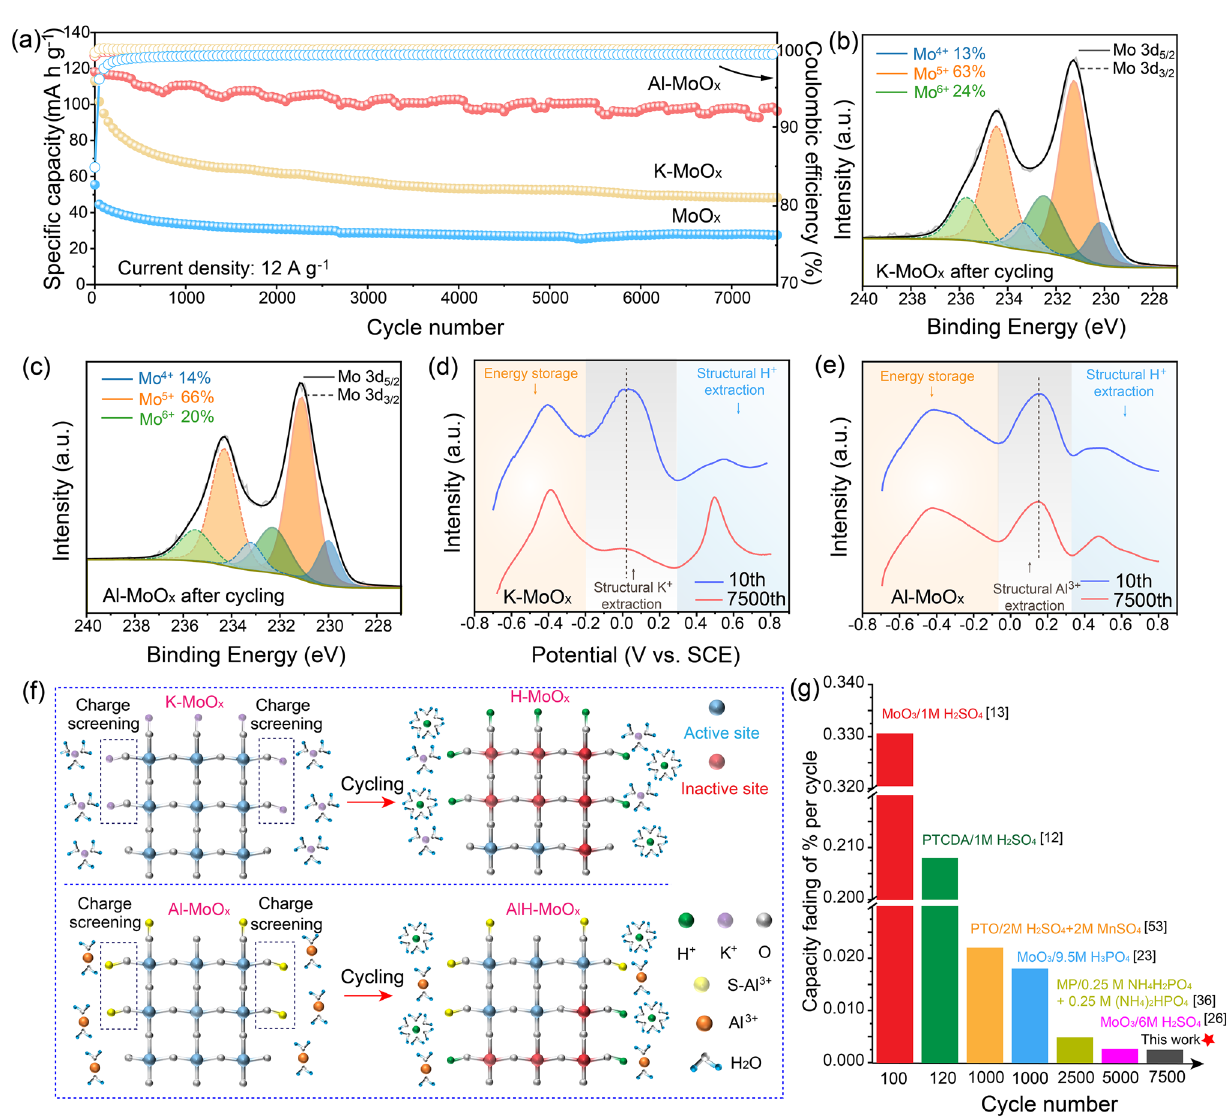
Fig. 4 Analysis of high cyclic stability. a Cycling stability of MoO x , K-MoO x and Al-MoO x . Mo 3d XPS spectra of b K-MoO x and c Al-MoO x after 7,500 cycles. LSV curves of structural cation extraction for d K-MoO x and e Al-MoO x before and after cycling. f Schematic illustration of energy storage mechanism of K-MoO x and Al-MoO x after cycling. g Cycling performance comparison between this work and the related